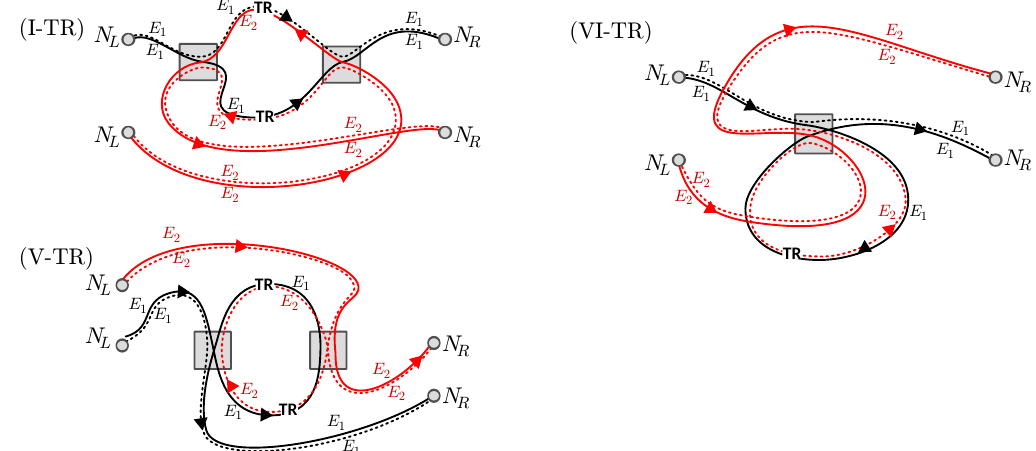
(cid:10) δ T ( ) δ T ( E ) (cid:11) which contain some E Figure 6: Leading order in 1 / N contributions to 1 2 time-reversed (TR) trajectory-pairs (some of the trajectory pairs consist of trajectories going in opposite directions). These time-reversed trajectory-pairs are marked with “TR”, such trajectory-pairs are cooperons in the language of disordered systems. Each diagram here corresponds on one in Fig. 5, but with the red trajectories passing though the encounters in the opposite way. However, this is not possible for the contributions in Fig. 5 with encounters at the leads (contributions II, III, and IV), meaning there are only the above three diagrams containing TR